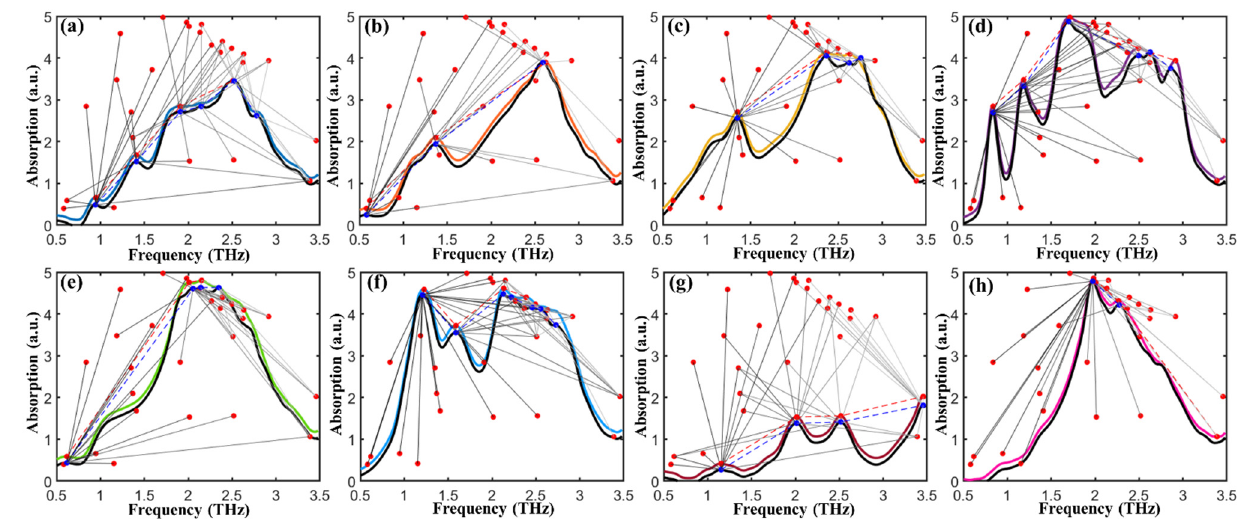
Figure 4. Feature points searching and matching for ( a ) fentanyl, ( b ) methoxyacetylfentanyl, ( c ) acetylfentanyl, ( d ) furanylfentanyl, ( e ) butyrylfentanyl, ( f ) 4-fluoroisobutyrfentanyl, ( g ) carfentanil, and ( h ) valerylfentanyl.